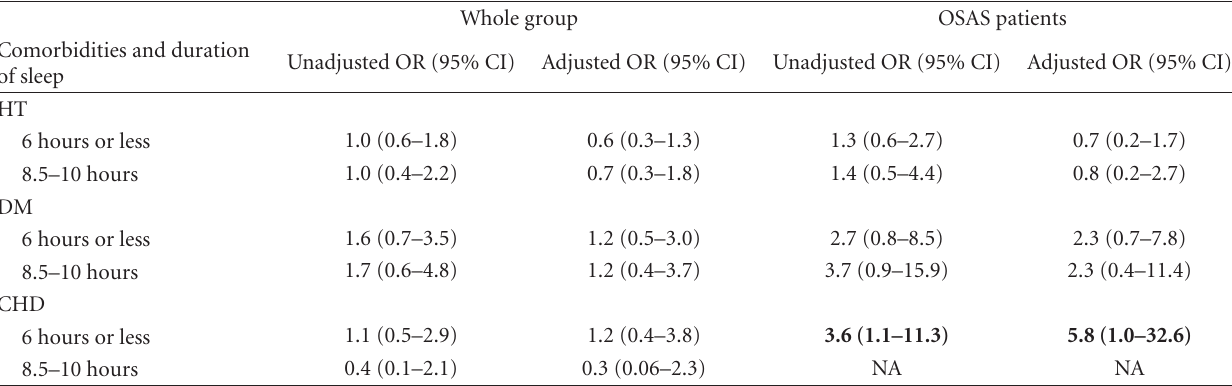
Table 3: Association between reported sleep duration and cardiovascular and metabolic comorbidities in the models adjusting for other risk factors. Whole group OSAS patients Comorbidities and duration Unadjusted OR (95% CI) Adjusted OR (95% CI) Unadjusted OR (95% CI) Adjusted OR (95% of sleep